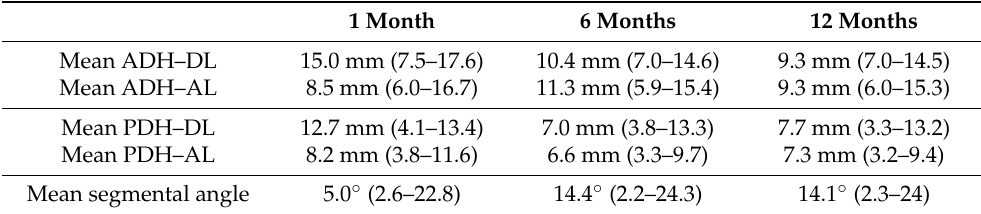
Table 2. Results on radiological studies at 1, 6 and 12 months of